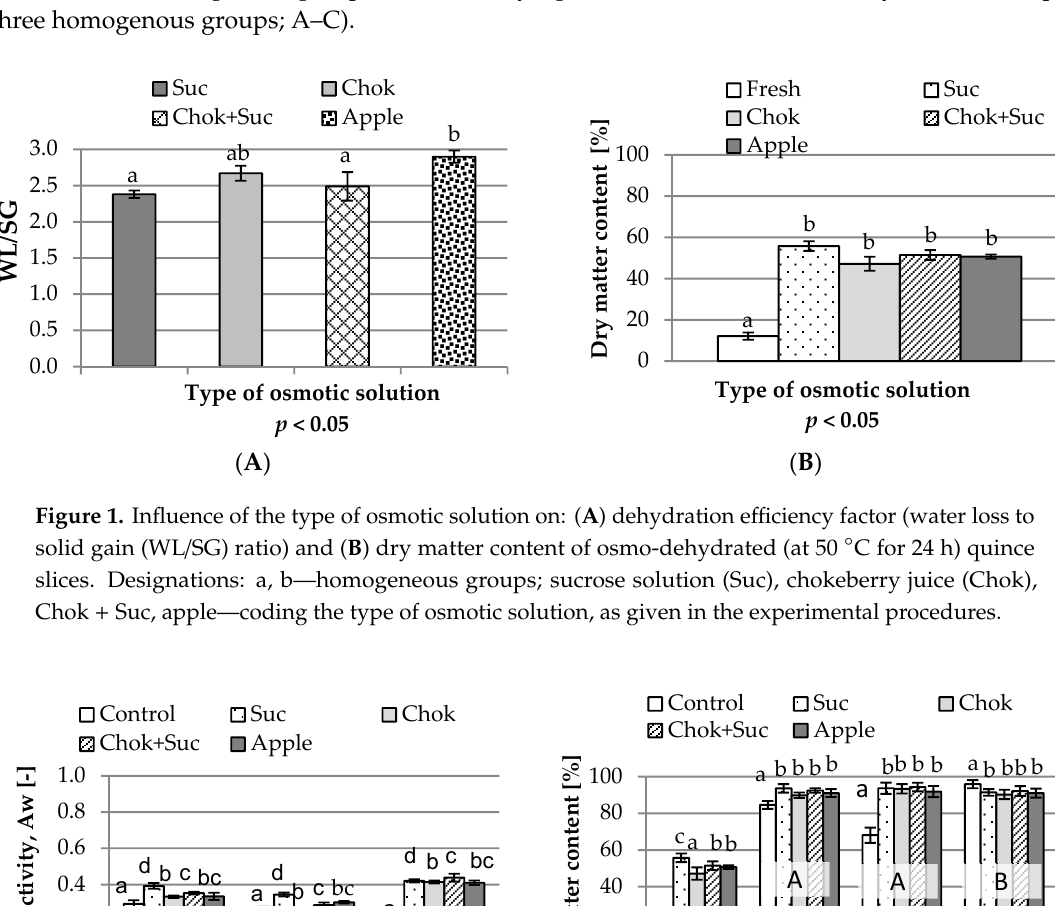
Figure 1. Influence of the type of osmotic solution on: ( A ) dehydration efficiency factor (water loss to solid gain (WL/SG) ratio) and ( B ) dry matter content of osmo-dehydrated (at 50 °C for 24 h) quince slices. Designations: a, b—homogeneous groups; sucrose solution (Suc), chokeberry juice (Chok),